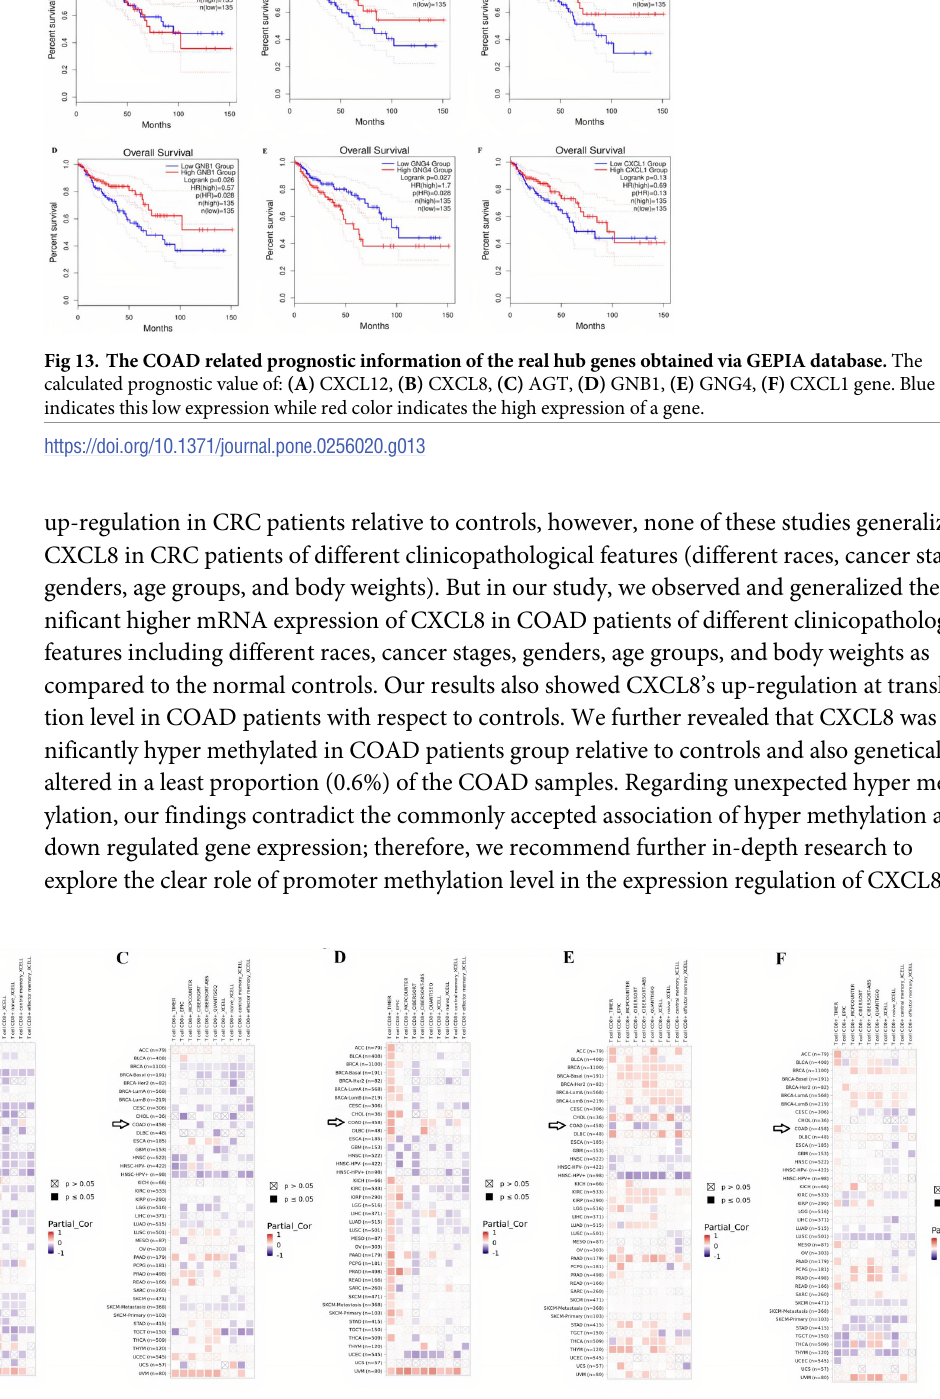
Fig 14. TIMER based Spearman correlational analysis between the expression of real hub genes and CD8+ T immune cell infiltration in COAD. TIMER based Spearman correlational analysis between: (A) CXCL12 expression and CD8+ T immune cell infiltration; (B) CXCL8 expression and CD8+ T immune cells’ infiltration; (C) AGT expression and CD8+ T immune cells’ infiltration; (D) GNB1 expression and CD8+ T immune cells’ infiltration; (E) GNG4 expression and CD8 + T immune cells’ infiltration; (F) CXCL1 expression and CD8+ T immune cells’ infiltration. Red color box represents the positive correlation; blue color represents the negative correlation while white color represents no correlation. A p-value of < 0.05 was considered as significant.